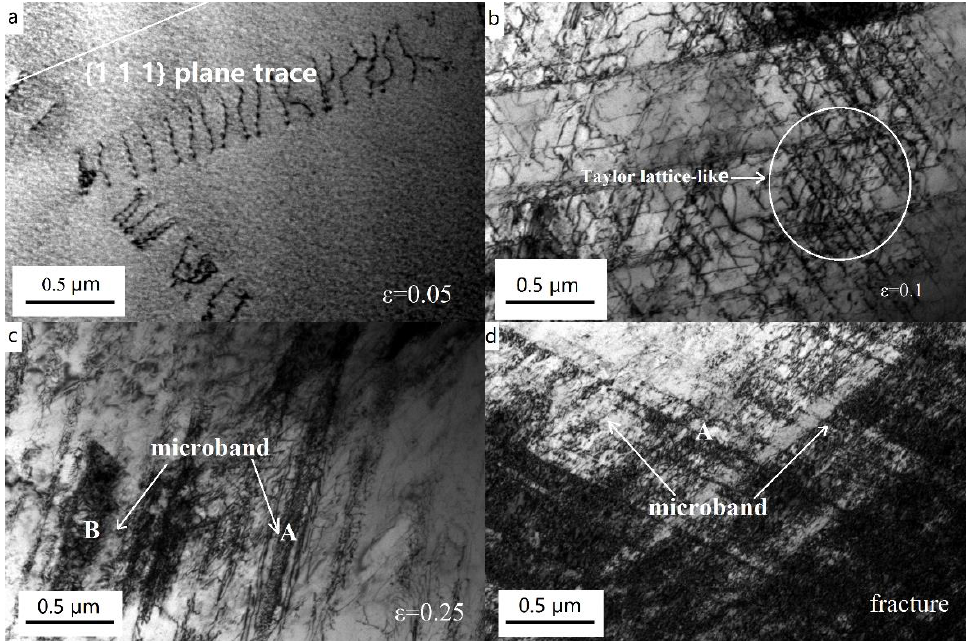
Figure 10. TEM micrographs of the Fe – 28Mn – 10Al – C – 0.5Nb low-density steel after interrupted at different strains during room temperature tensile deformation of ( a ) 5%, ( b ) 10%, ( c ) 25%, and ( d ) failure to fracture. Metals 2021 , 11 , x FOR PEER REVIEW